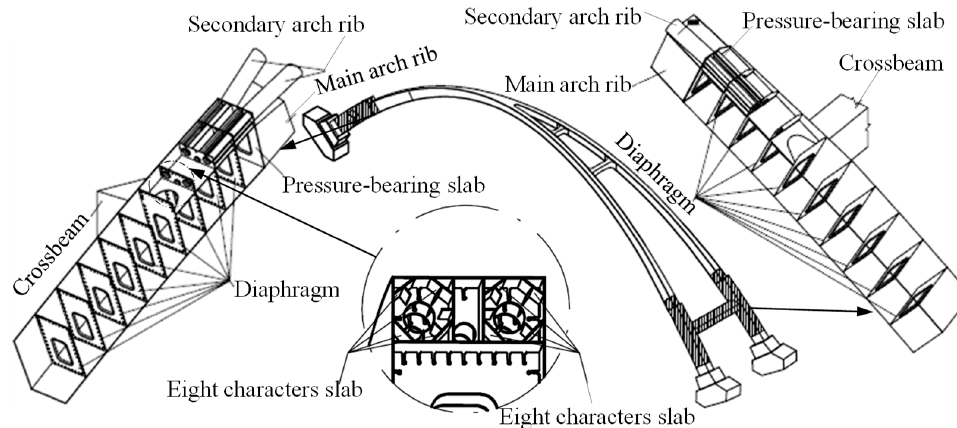
Figure 5. Setting of arch foot bearing slab and diaphragm.